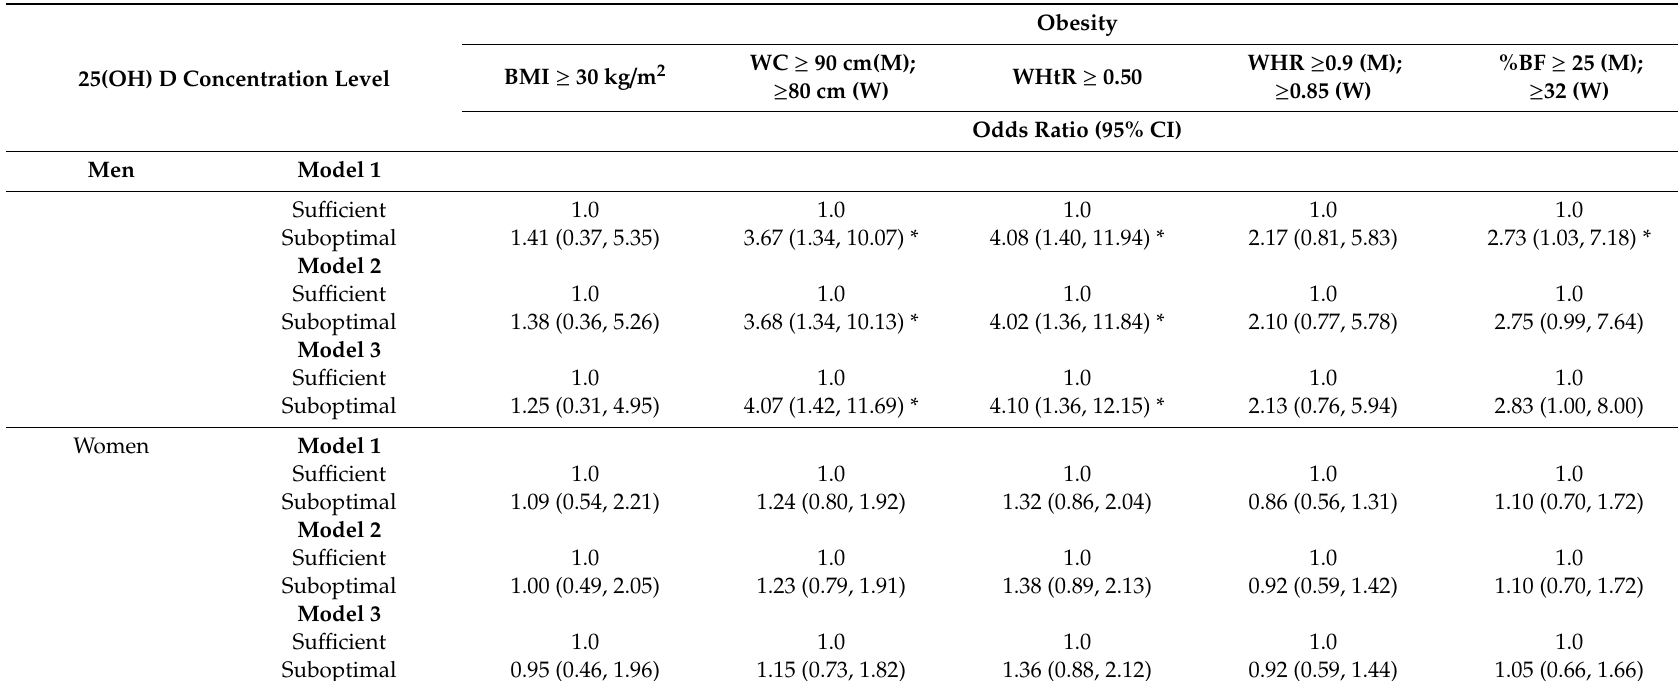
Table 4. Association between 25 (OH) D concentration level and obesity status in men and